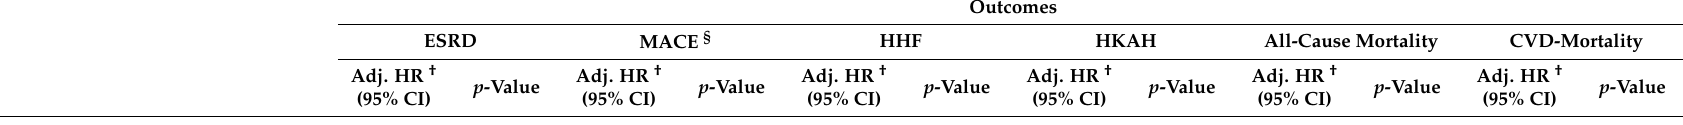
Table 4. Sensitivity